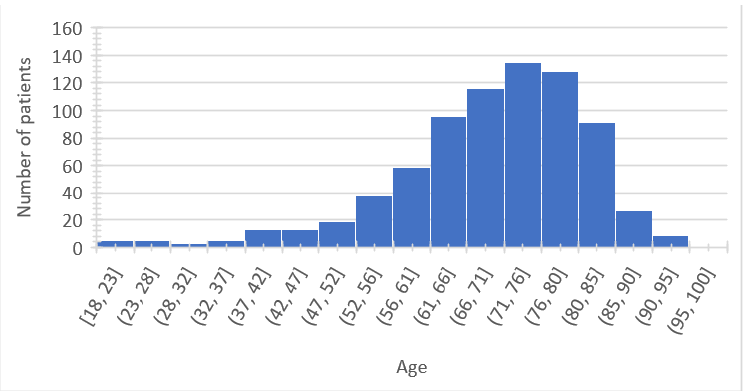
Figure 4. Histogram of patients’ age representation.